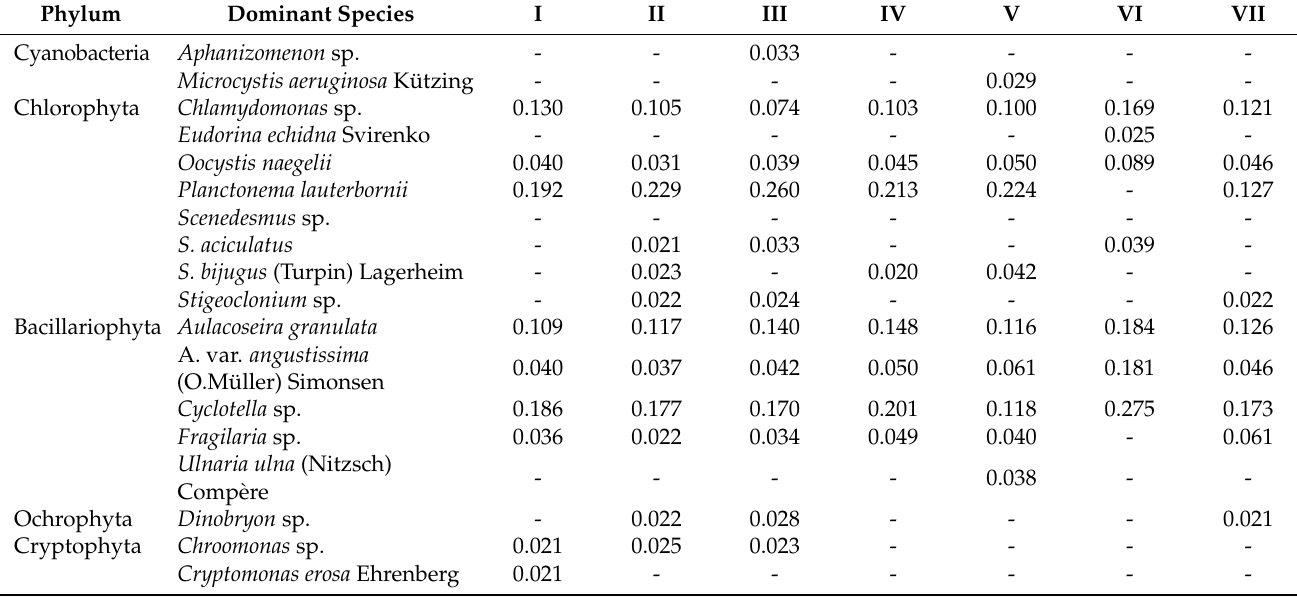
Table 2. Dominant species and dominant degree of phytoplankton in the Danjiangkou Reservoir.